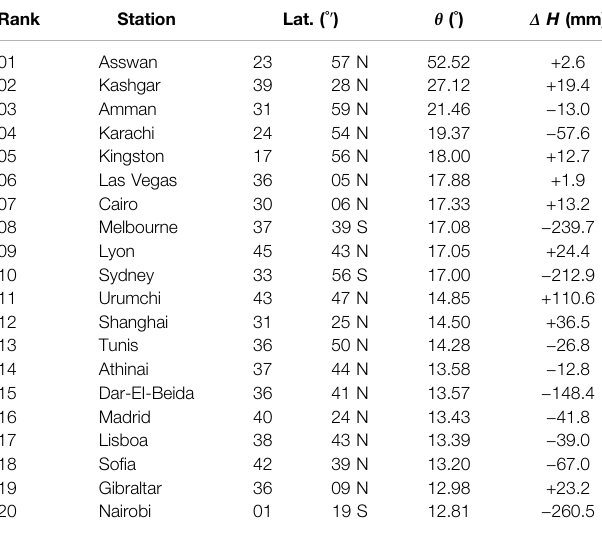
TABLE 2B | Top-twenty World stations in the intersecting angle of the monthly precipitations from Period II (from 1951 to 1980) to Period III (from 1981 to